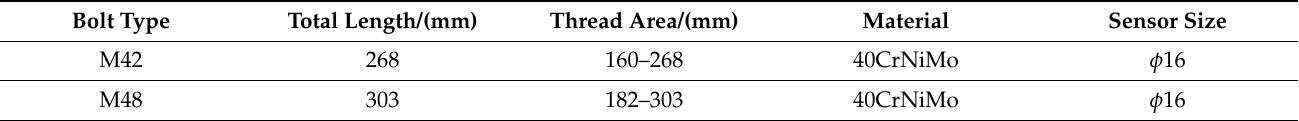
Table 1. Specification for bolts with film